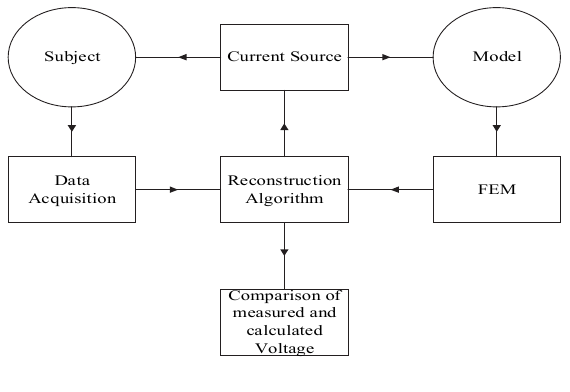
Fig. 8: Block diagram of the EIT system redrawn from